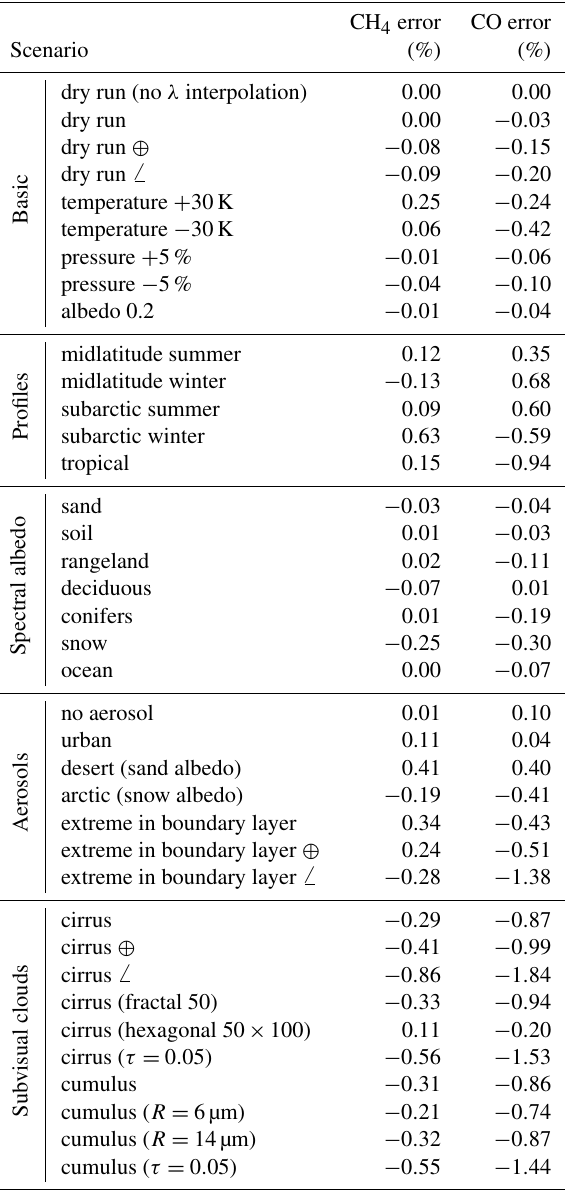
Table 2. Error analysis for different scenarios. Standard settings are direct nadir, sea level, solar zenith angle 50 ◦ , albedo 0 . 1, and US Standard Atmosphere. Scenarios with ⊕ include scaling of the CH 4 and CO profiles by 10%; for scenarios with the sensor zenith angle is set to 30 ◦ (relative azimuth 60 ◦ ). Standard cirrus clouds are located between 11 and 12km (cloud optical thickness τ = 0 . 03), consisting of fractal ice crystals with an edge length of 100µm. Standard cumulus clouds are located between 3 and 4km ( τ = 0 . 03), consisting of water droplets with an effective radius R of